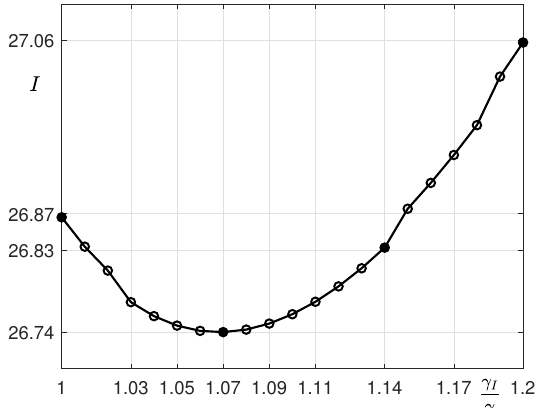
Figure 6. Total incentive I with respect to γ I